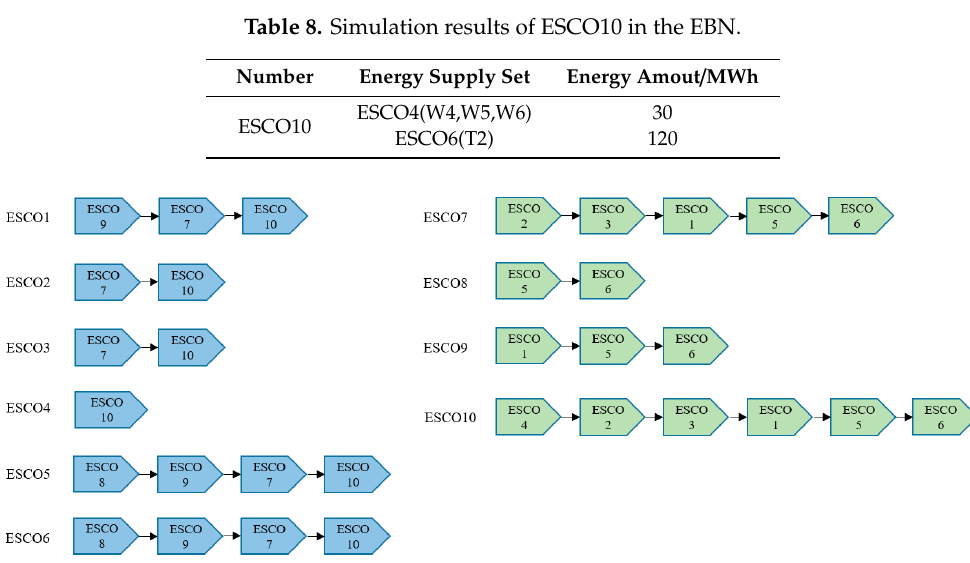
Figure 7. The initial matched pairs of energy service companies (ESCOs). Energies 2019 , 12 , x FOR PEER REVIEW